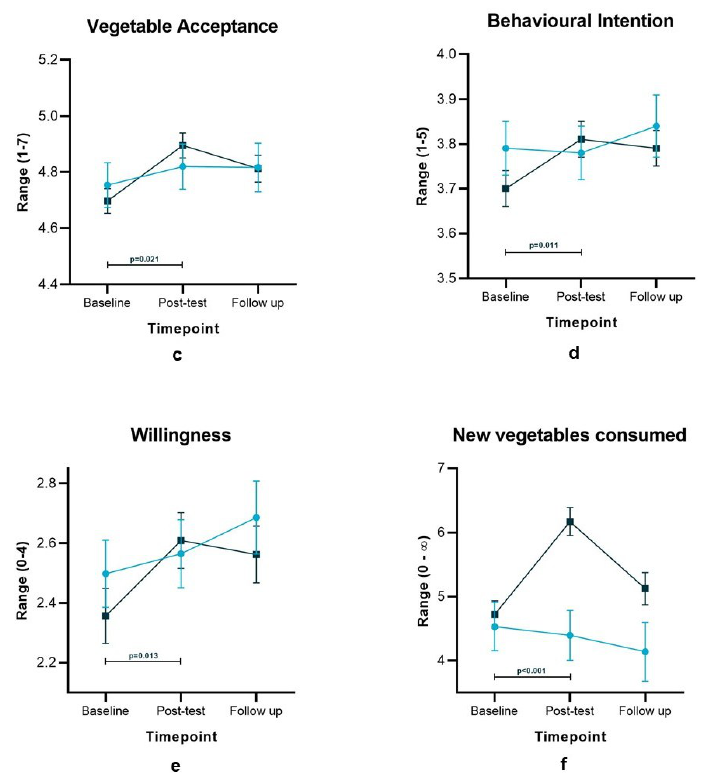
Figure 2. Changes in outcomes over time in both intervention groups combined compared to the control group in ( a ) knowledge about vegetables and the senses, ( b ) ability to verbalize sensations, ( c ) vegetable acceptance, ( d ) behavioural intentions, ( e ) willingness to eat vegetables, ( f ) number of new vegetables consumed. p -value on the di ff erence in intervention * time point interaction e ff ect between the intervention and control. Table 4. Di ff erence in student outcomes over time between students who have received the vegetable education regardless of intensity of teacher training (intervention) and students who followed their regular curriculum